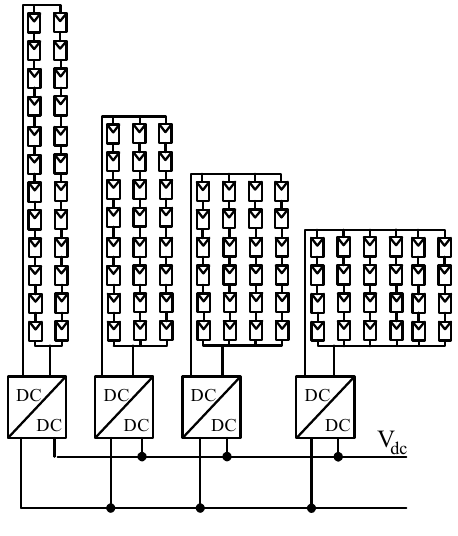
Figure 32. DMPPT power processing scheme for multi-junction PV cells. Each substring is formed by grouping subcells of the same wavelength (material) together [73].